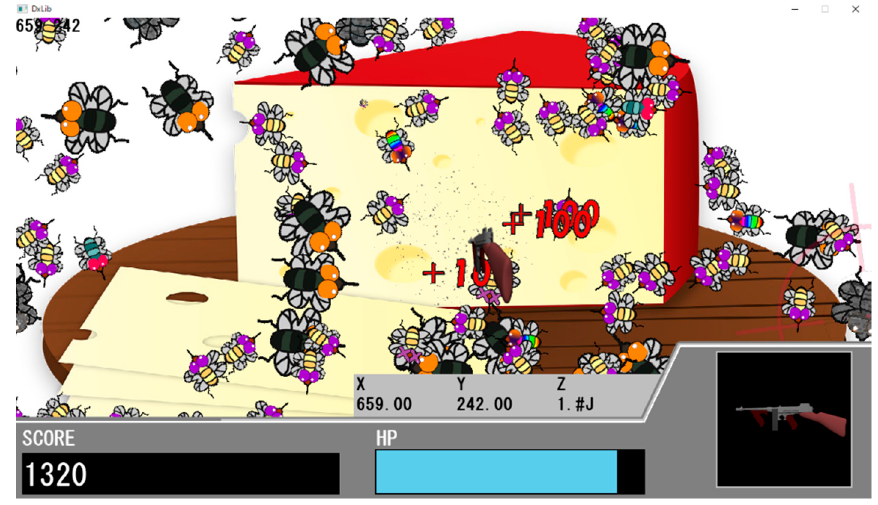
Figure 1. Screenshot exemplifying the “fly-tapping game”.